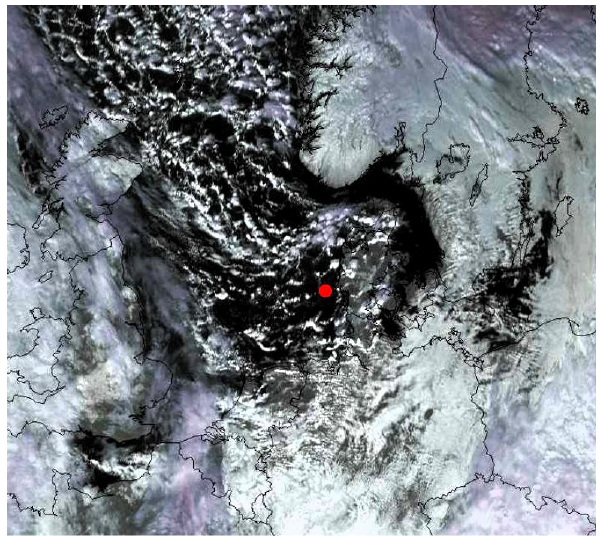
Figure 2. Satellite image of the 8 February 2009 12:00UTC by Meteosat. The red dot marks the study domain above the North Sea (Fig. 3).